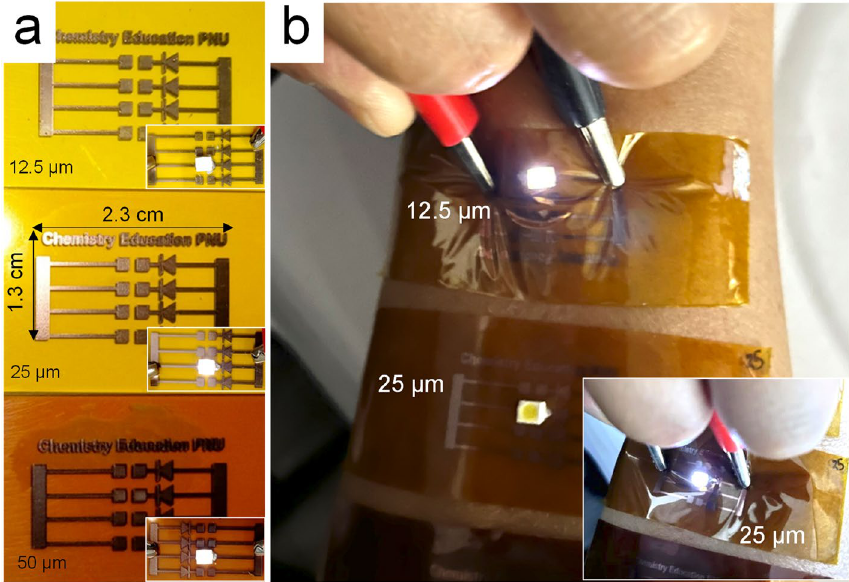
Figure 9. Various Cu patterns designed for testing electrical connections with LEDs: ( a ) Cu patterns formed on PI films with different thicknesses (12.5, 25, and 50 μm) attached to a glass plate and ( b ) LEDs operating on the Cu patterns of PI films attached to the arm